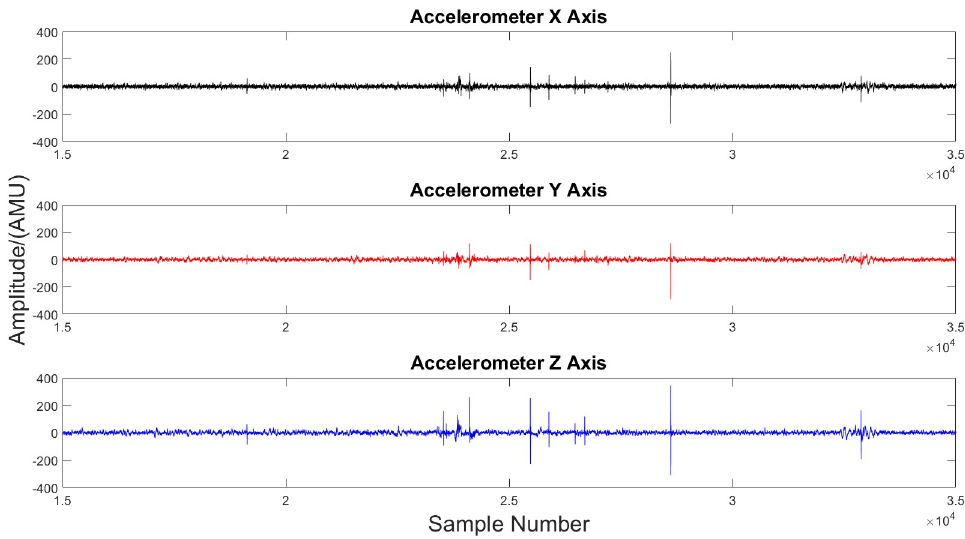
Fig 2. The accelerometric data along the three axes, X-Axis, Y-Axis and Z-Axis. The raw time domain data captured from the sensor are visualized in this figure. The acceleration recorded along the three axes can be observed separately. The acceleration recorded at each instance is plotted against the sample number.